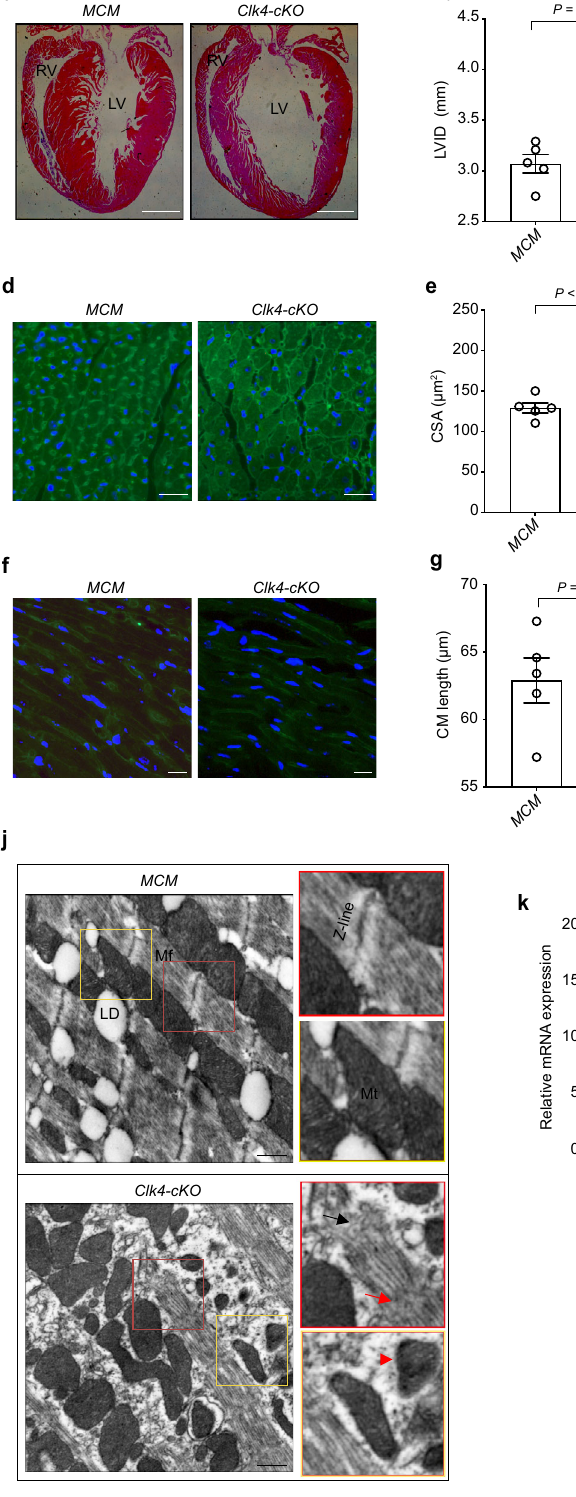
mitochondrion, Mf myo fi bril, LD lipid droplet, red asterisk, mitochondria; red arrow, blurred and widened Z-disks; black arrow, ruptured myo fi bril. Scale bars: 500nm. k qPCR analysis of cardiac hypertrophic genes, including Nppa , Nppb and Myh7 . For b , c , e , g , i and k , n =5 animals per group. All statistical analyses wereperformedusingunpaired,two-tailedStudent ’ s t test.Dataarepresentedas themeans±S.E.M.; P valuesareshownineachgraph.Sourcedataareprovidedas a Source Data fi le.